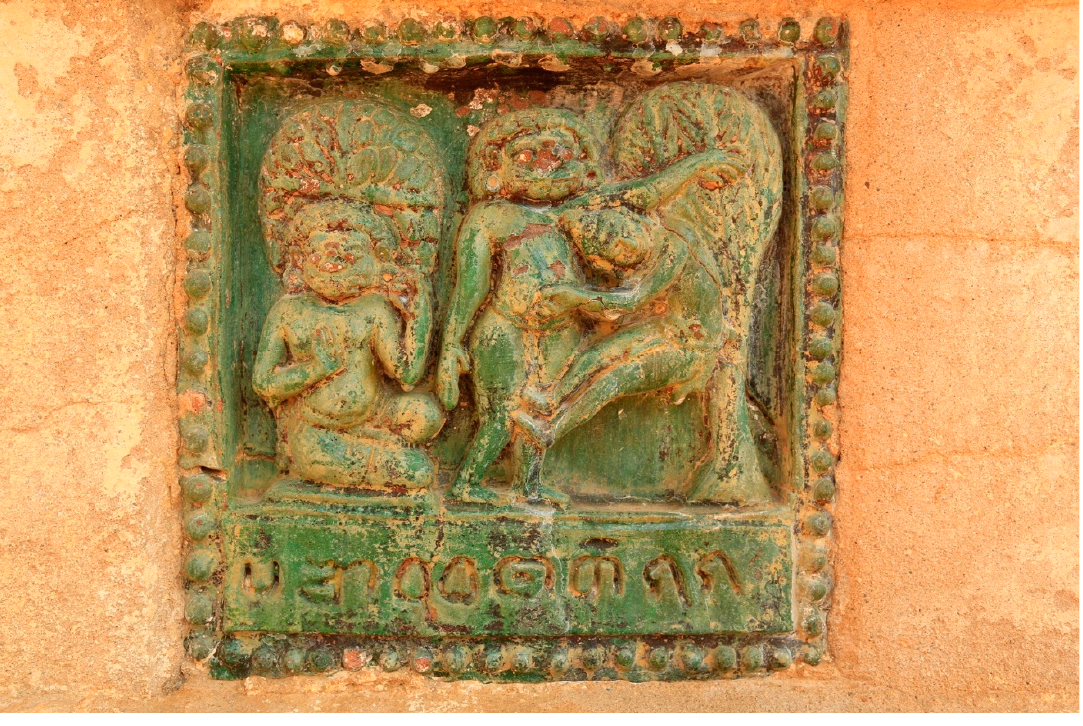
Figure 22. Pagan, Ananda, 11th century. Khadirang ā ra J ā taka 40.